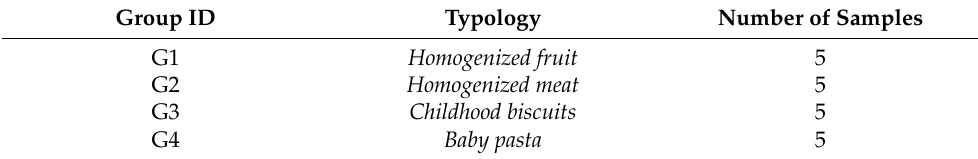
Table 1. Group identification code (ID), typology and number of samples for each group. Group ID Typology Number of Samples G1 Homogenized fruit 5 G2 Homogenized meat 5 G3 Childhood biscuits G4 Baby pasta